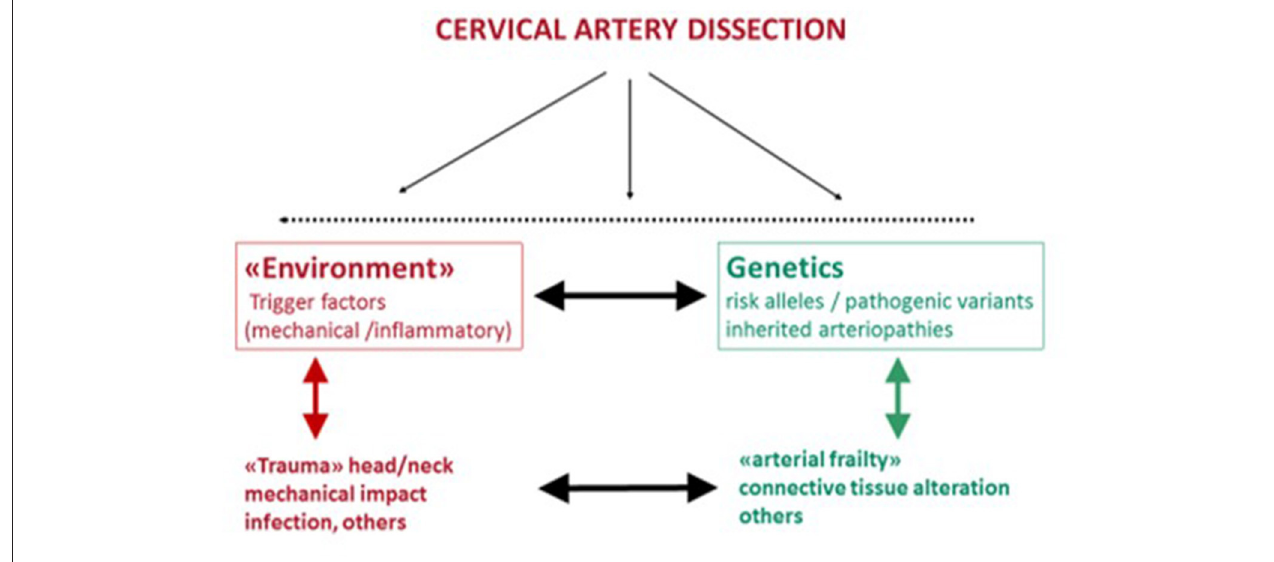
FIGURE 1 | Etiology of CeAD as a multifactorial disease with environmental and genetic risk determinants that probably